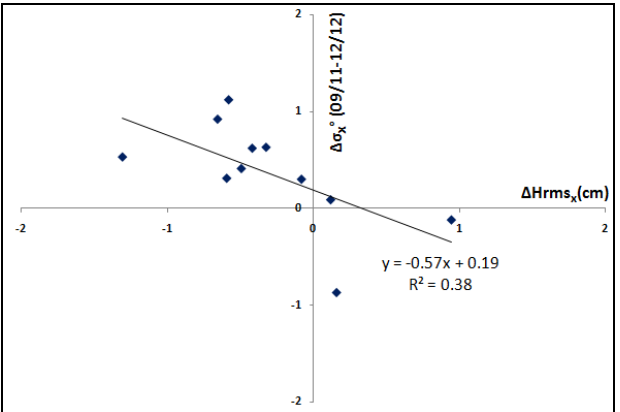
Figure 4. Relationship between temporal variations in radar signal (  σ X° ) and soil roughness changes (  rms X ) over test fields, between the two driest images (9 November, and 12 December